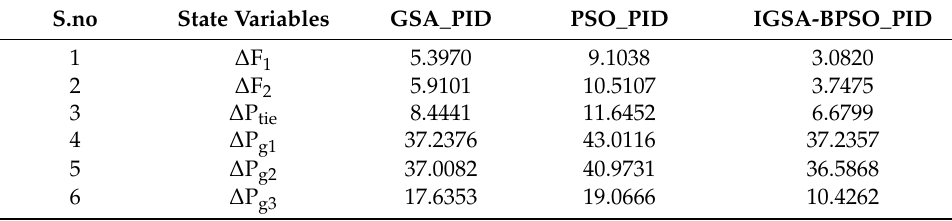
Table 8. Settling time values (s) for different optimization techniques (O.T.)–CVT.